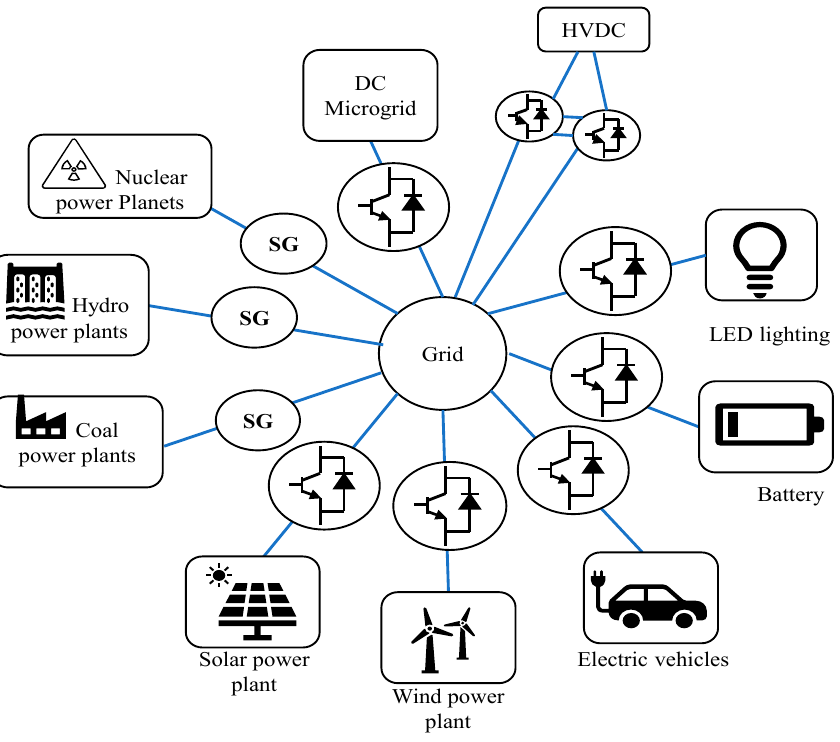
Figure 1. Integration of power electronic interface distributed generation into the future power system [6,10].